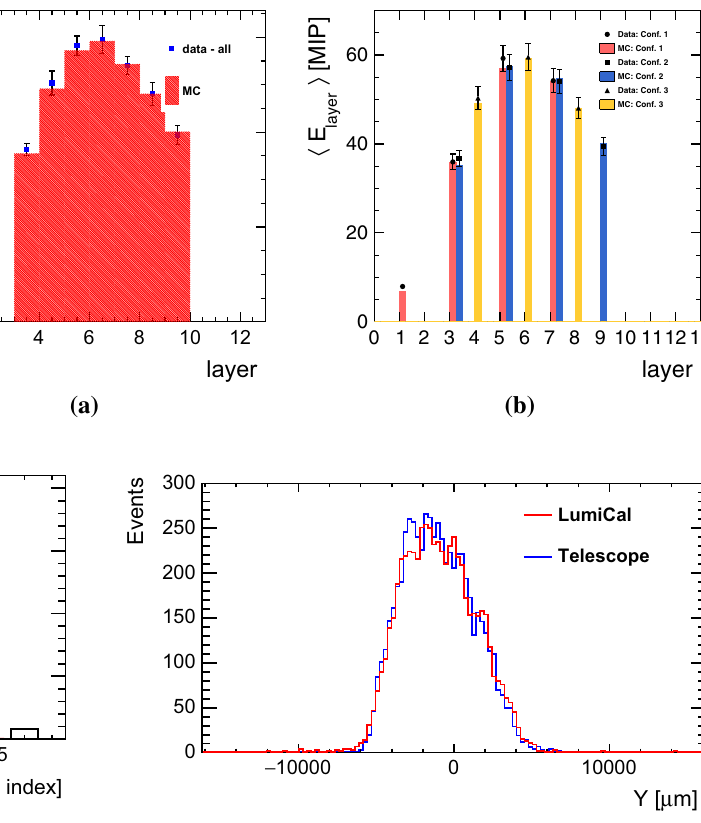
Fig. 20 The deposited energy sum for a single event, E n , as a function of Y expressed in terms of the pad number. The curve is a Gaussian fit to the data